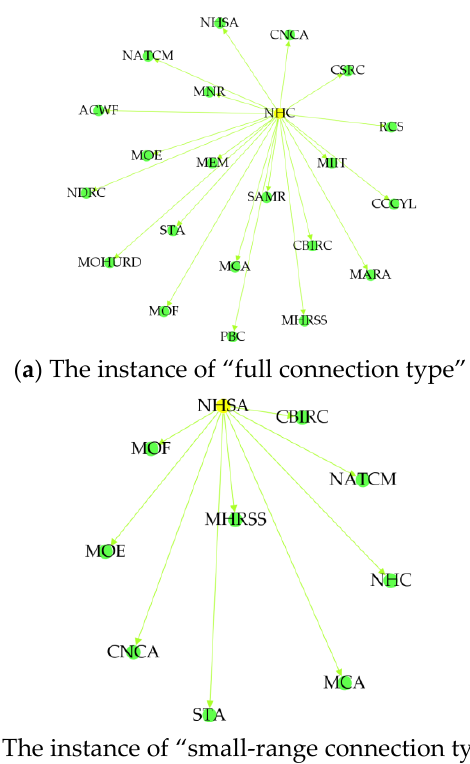
Figure 3. The global visualization result of the HnICN.